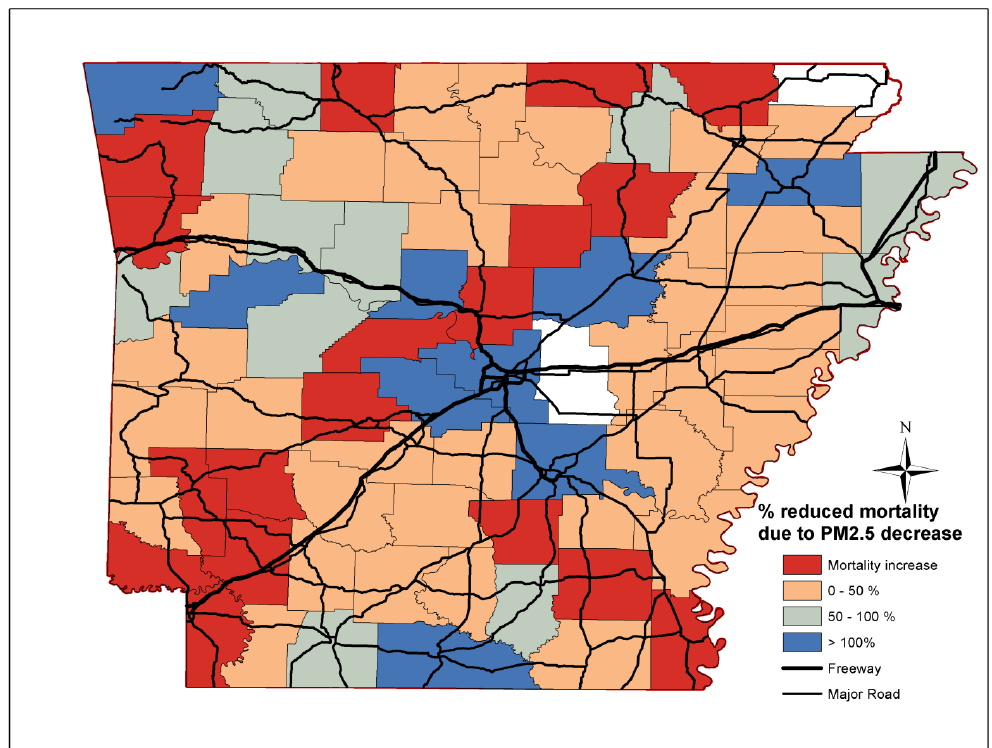
Figure 4. Percentage reduction of cardiovascular mortality attributed to PM for each Arkansas